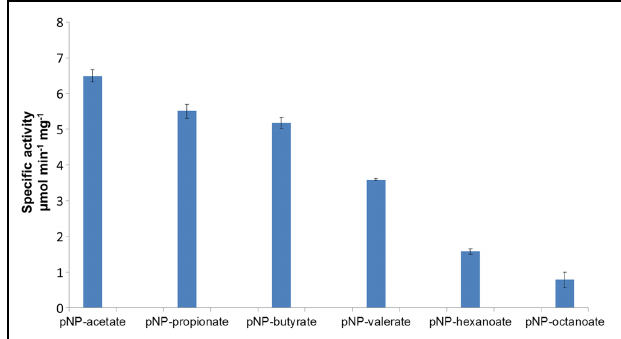
FIGURE 1 | The specific activity of the native TtEst2 toward p NP-esters with varying carbon chain lengths. The enzyme activity was measured by monitoring p NP production (Armstrong et al.,